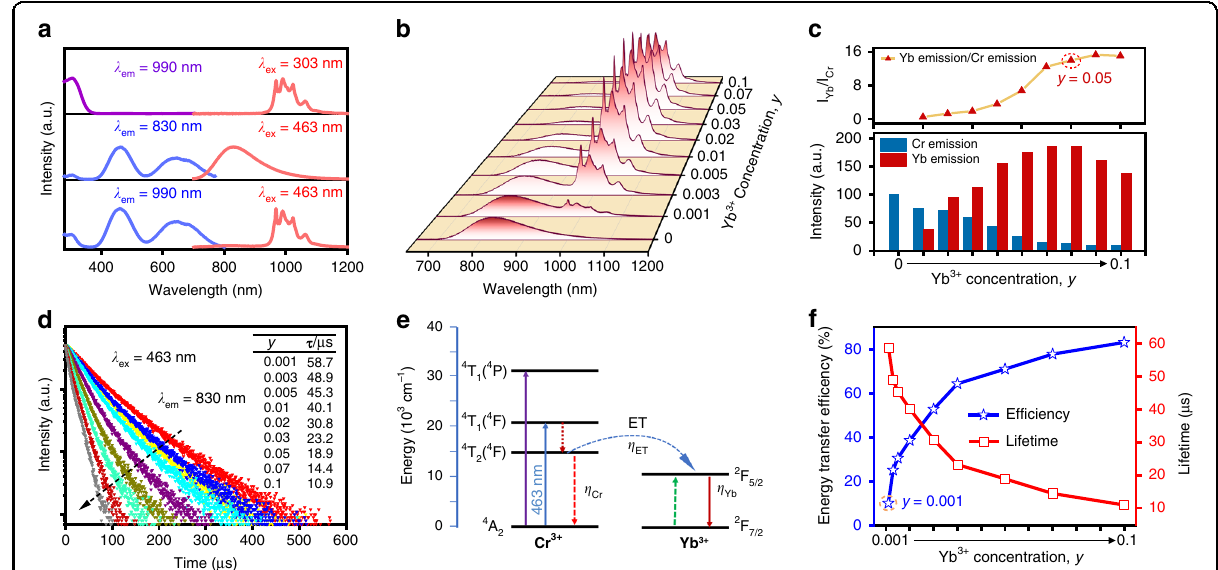
Fig. 3 SWIR luminescence properties of Lu 0.2 Sc 0.8 BO 3 :Cr 3 + ,Yb 3 + phosphors. a Photoluminescence emission and excitation spectra of Lu 0.2 Sc 0.8 BO 3 :5%Yb 3 + , Lu 0.2 Sc 0.8 BO 3 :2%Cr 3 + , and Lu 0.2 Sc 0.8 BO 3 :2%Cr 3 + ,5%Yb 3 + phosphors. b Photoluminescence emission spectra of Lu 0.2 Sc 0.8 BO 3 :2% Cr 3 + , y Yb 3 + ( y = 0 – 0.1) upon 463-nm-light excitation. c The ratio of Yb 3 + (940 – 1200 nm) SWIR emission to Cr 3 + NIR emission (650 – 940 nm), and Cr 3 + NIR emission intensity and Yb 3 + SWIR emission intensity in Lu 0.2 Sc 0.8 BO 3 :2%Cr 3 + , y Yb 3 + phosphors with varying Yb 3 + doping concentration. d Luminescence decay curves of Cr 3 + in Lu 0.2 Sc 0.8 BO 3 :2%Cr 3 + , y Yb 3 + phosphors monitored at 830 nm with different Yb 3 + concentration. e Schematic representation of Cr 3 + → Yb 3 + energy transfer. f The measured Cr 3 + lifetime and Cr 3 + → Yb 3 + energy transfer ef fi ciency at different Yb 3 +